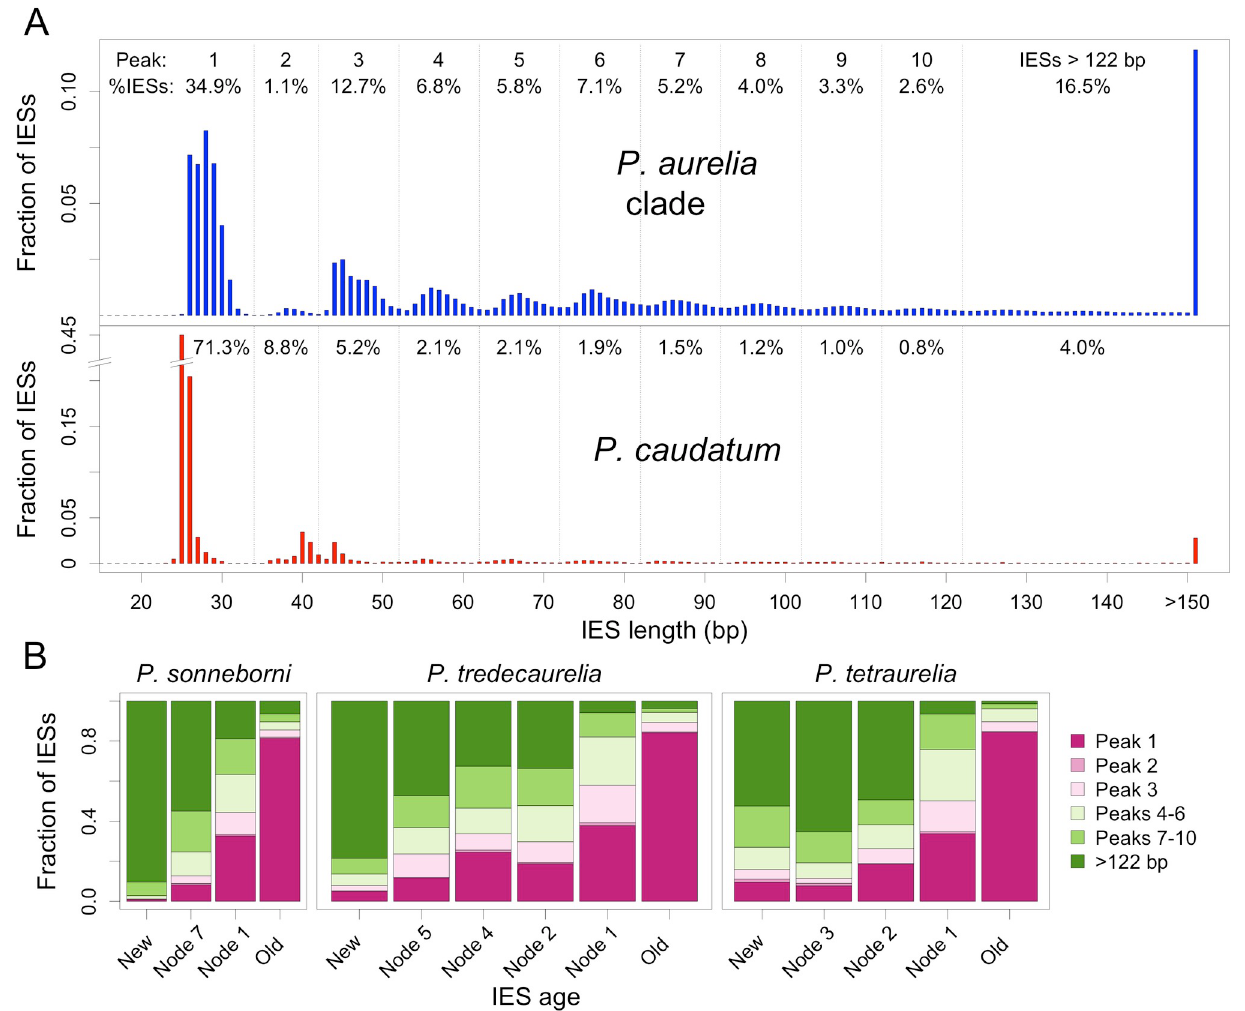
Fig 4. Length distribution of IESs according to their age. (A) Comparison of the length distribution of IESs in P . caudatum ( N = 8,172 IESs) and in species from the aurelia clade ( N = 392,082 IESs). The fraction of IESs present within each peak of the distribution is indicated for the first 10 peaks. (B) Comparison of the length distribution of IESs according to their age (for the subset of datable IESs located in coding regions). The age of IES insertions is defined as in Fig 3. Results from other species are presented in S11 Fig. The data underlying this figure may be found at https://doi.org/10.5281/zenodo. 4836464. IES, internal eliminated